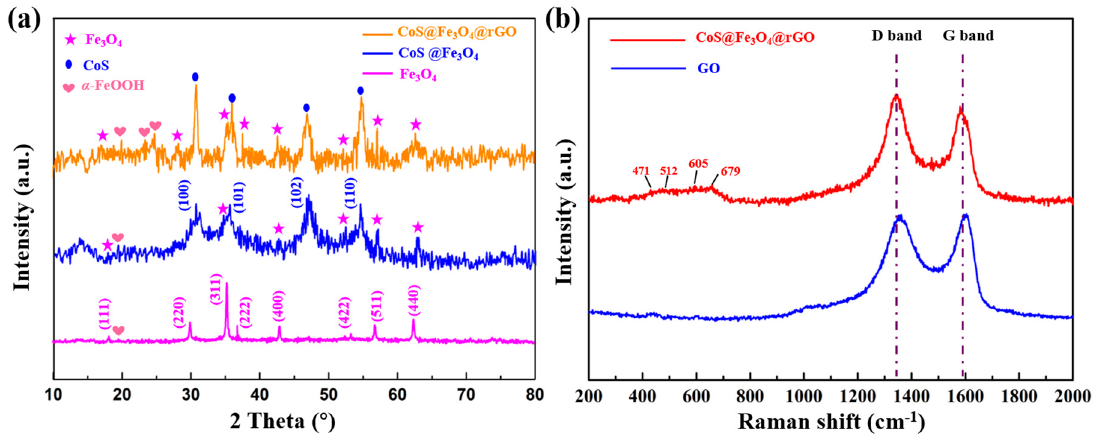
Figure 1. ( a ) X-ray powder diffraction (XRD) curves of Fe 3 O 4 , CoS@Fe 3 O 4, and CoS@Fe 3 O 4 @rGO; ( b ) Raman spectra of graphene oxide (GO) and CoS@Fe 3 O 4 @rGO.